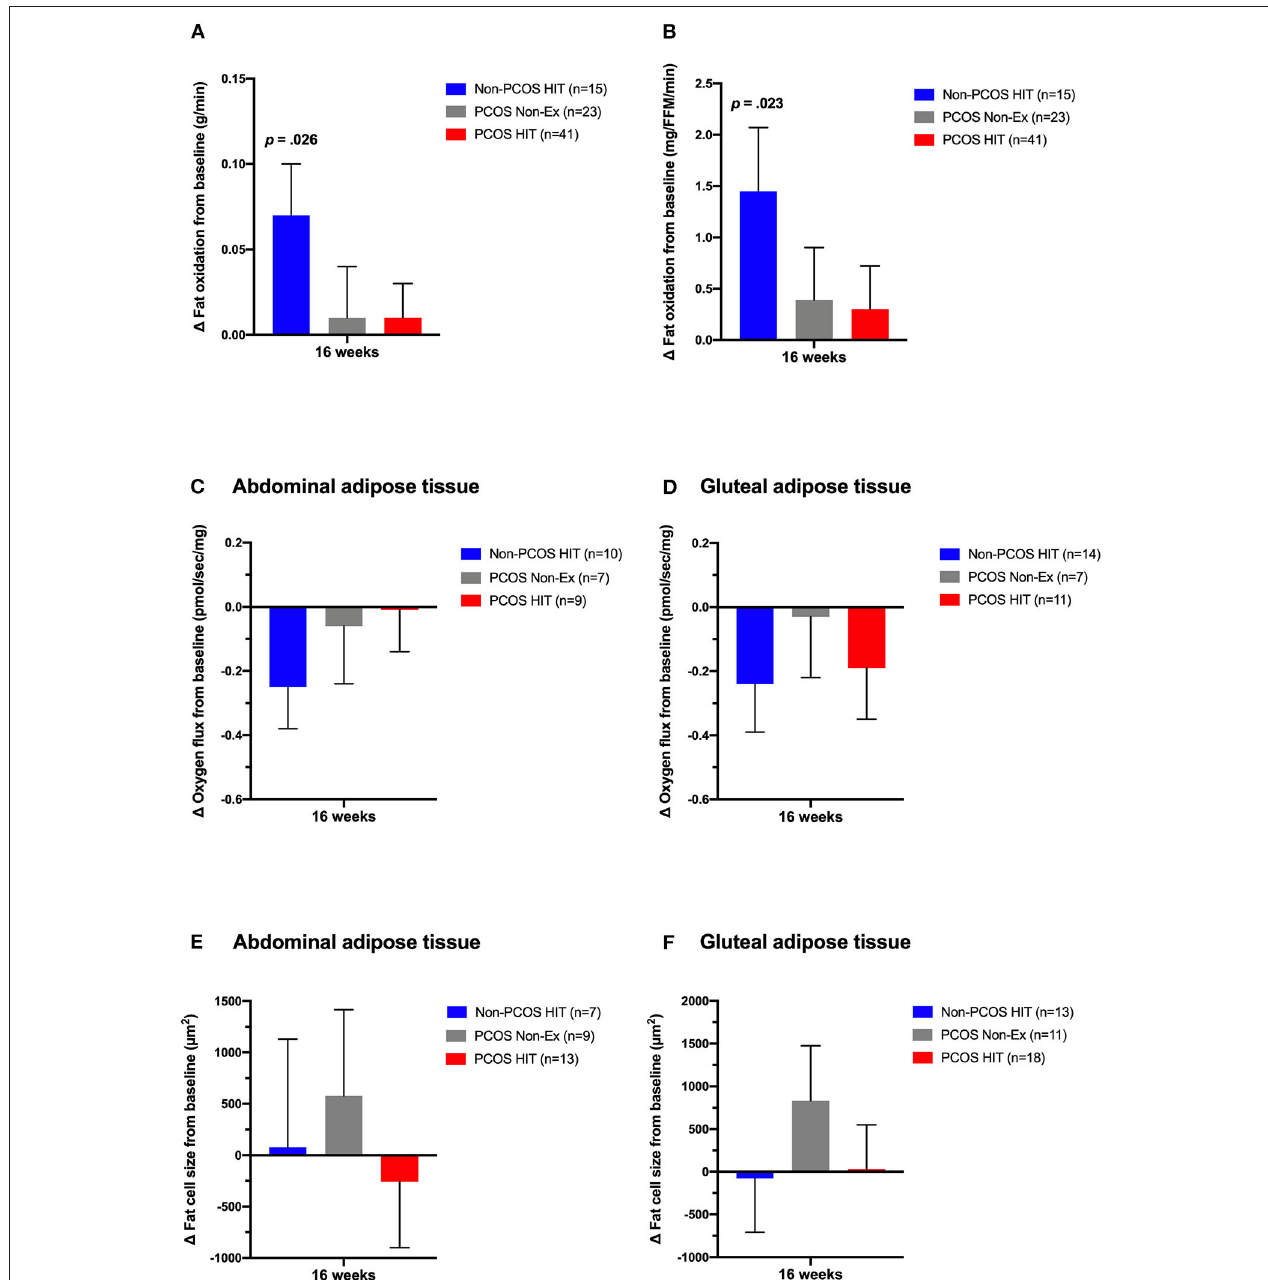
FIGURE 3 | Effects of 16 weeks of non-exercise or high-intensity interval training. Whole-body fat oxidation during submaximal exercise (A,B) , oxygen flux with complex I + II linked substrates in subcutaneous abdominal (C) and gluteal adipose tissue (D) , and abdominal (E) and gluteal (F) adipose tissue cell size in Non-PCOS HIT (blue bars), PCOS Non-Ex (gray bars), and PCOS HIT (red bars) after the 16 weeks intervention. The bars and error bars represent estimated means and SE based on linear mixed models. P- values are for within-group comparisons after 16 weeks of high-intensity interval training.